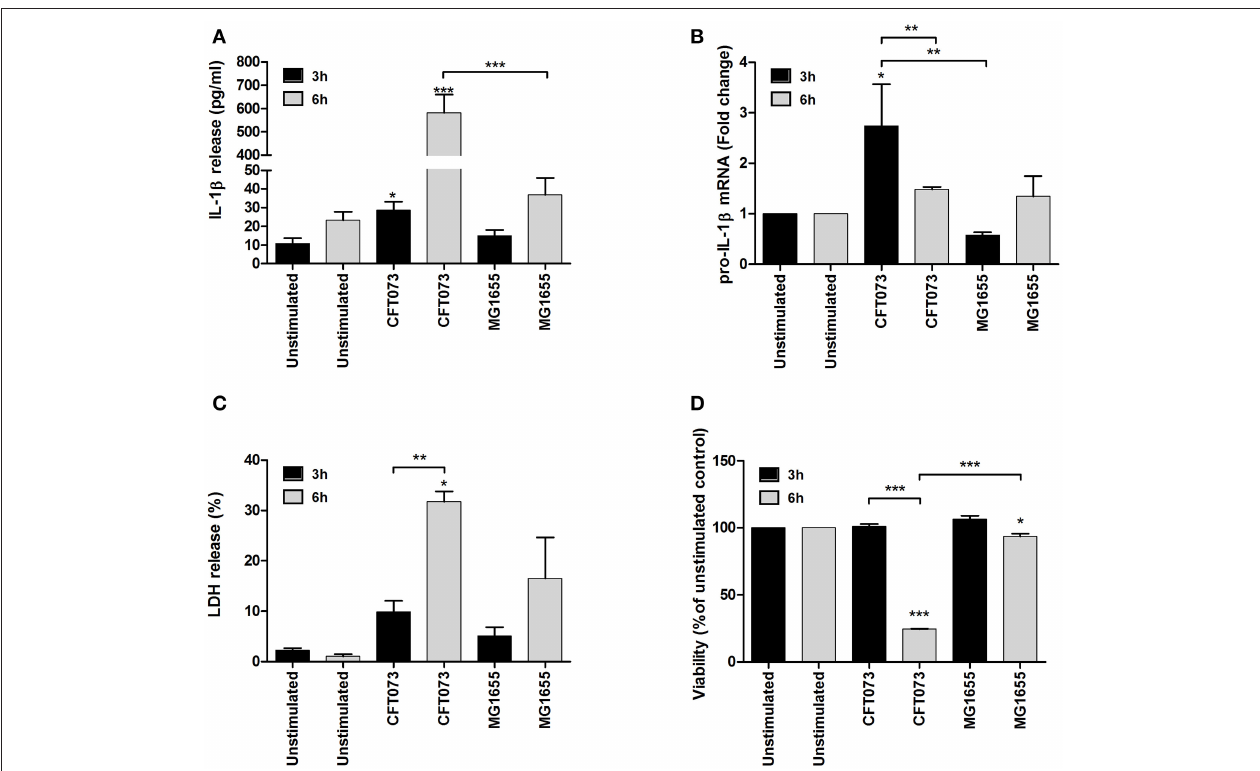
FIGURE 1 | IL-1 β release and cell viability analysis. The bladder epithelial cell line 5637 was infected with UPEC strain CFT073 and the non-pathogenic E. coli strain MG1655 at MOI 10 for 3 and 6h followed by analysis of IL-1 β release (A) , pro-IL-1 β mRNA expression (B) , LDH release (C) and neutral red staining (D) . Pro-IL-1 β expression was normalized to GAPDH and expressed as fold change relative to unstimulated controls. LDH release is presented as % of total LDH and neutral red as % of unstimulated controls. Data are presented as mean ± SEM ( n = 3 independent experiments). Asterisks denote statistical significance compared to